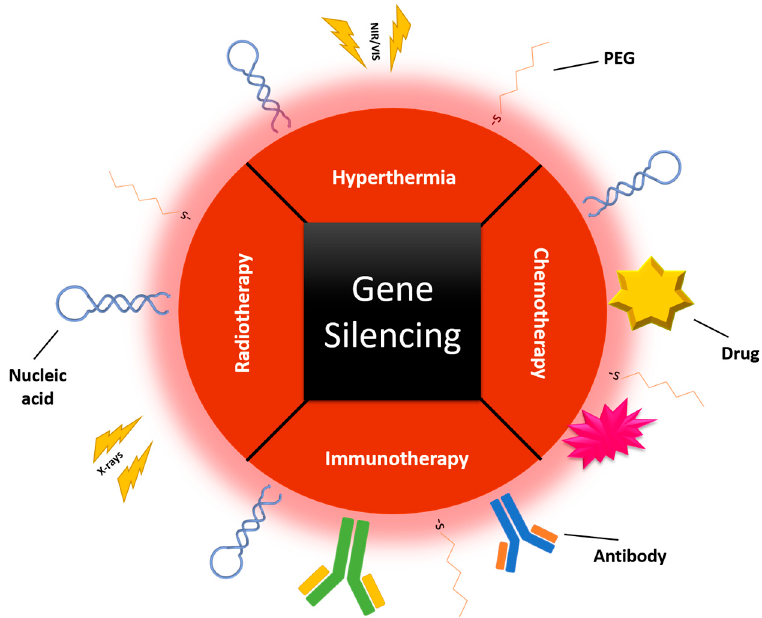
Figure 1. Combinatory therapy in one gold nanoparticle (AuNP), including gene silencing and other therapeutic approaches, such as chemotherapy, hyperthermia, radiotherapy, and/or immunotherapy. PEG: polyethylene glycol; NIR/VIS: Near Infra ‐ Red/Visible